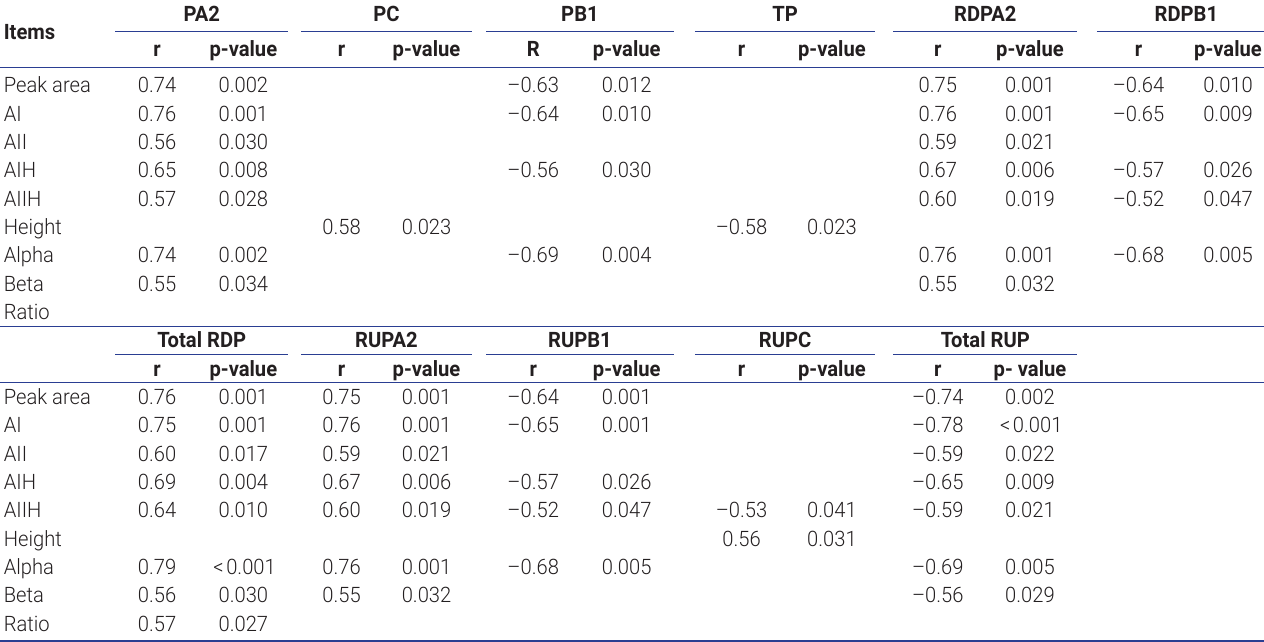
Table 13. Correlation study between FTIR protein structures and the protein portions of the CNCPS profile of canola seeds Items